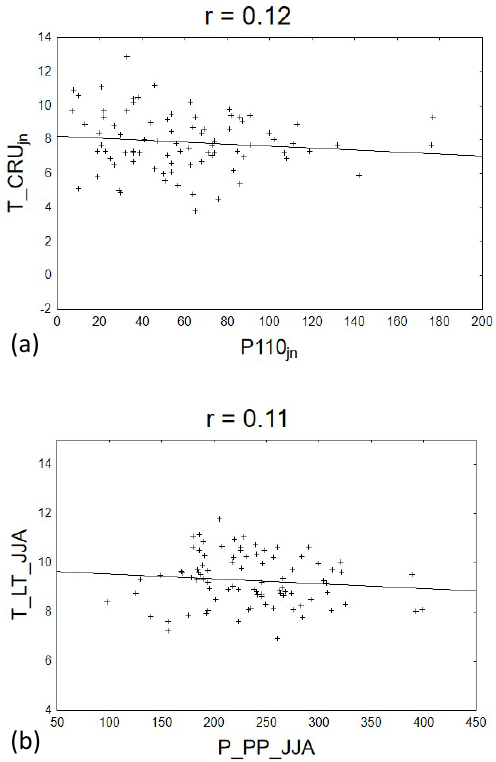
Figure 6. Correlation between temperature and precipitation com- mon with overlapping (a) month (June), (b) season (JJA) signifi- cant for radial increment formation. Low correlation between the climatic variables in both cases ( r = 0.12 and r = 0.11) confirms that climate regime for growing processes of spruce is not an in- versely proportional function of precipitation and